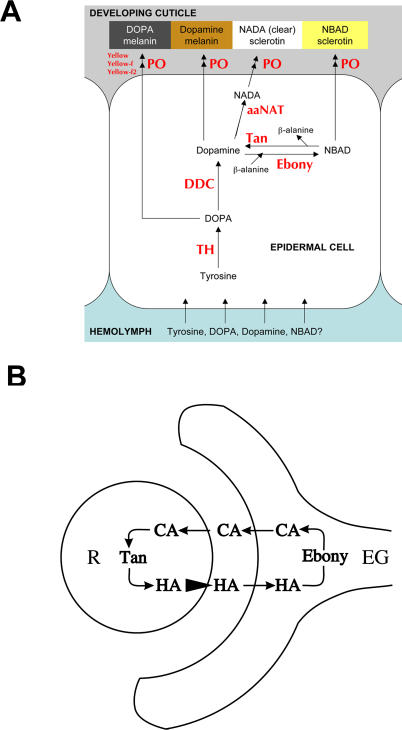
Tan Functions in Diverse Developmental and Metabolic Pathways(A) In developing adult epidermal cells, Tan catalyzes the production of dopamine from NBAD during pigment development. This is one of four parallel pathways by which dopa or dopamine derivatives are secreted into the developing cuticle as precursors for distinct pigments. aaNAT, arylalkylamine-N-acetyl transferase; DDC, dopa decarboxylase; NADA, N-acetyl dopamine; PO, phenol oxidase; TH, tyrosine hydroxylase.(B) In the photoreceptor, Tan catalyzes the hydrolysis of N-β-alanyl histamine (carcinine) to histamine for re-uptake by the presynaptic photoreceptor cell (R). CA, carcinine; EG, epithelial glial cell; HA, histamine.